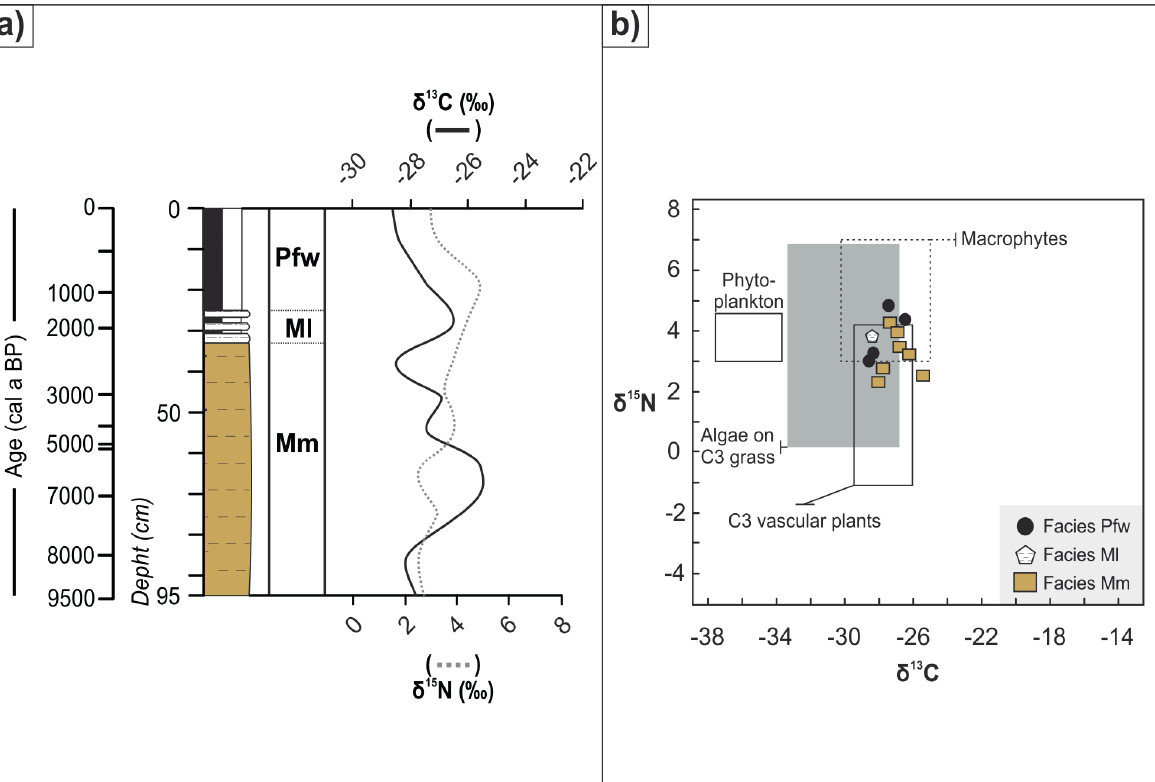
Figure 5 - a) Vertical profiles of the δ 13 C and δ 15 N values of the r4 core and b) binary plots of δ 13 C and δ 15 N based on hamilton and Lewis (1992) and Sahoo et al. (2015,